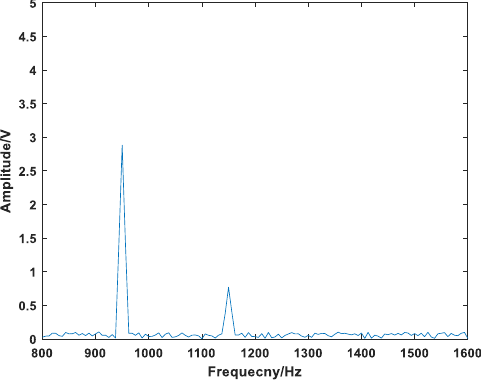
Figure 11. D2 layer DFT spectrum.